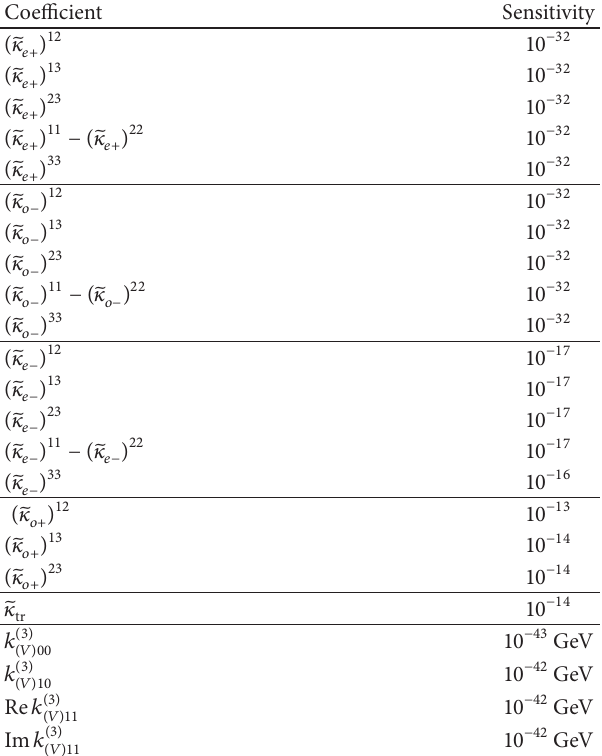
Table 2: Maximal sensitivities ( 2𝜎 ) for the photon sector (from [23]). The superscripts 𝑋, 𝑌 and 𝑍 there are converted to 1,2 and 3 here, respectively, for consistence with the notation of the Lorentz violation